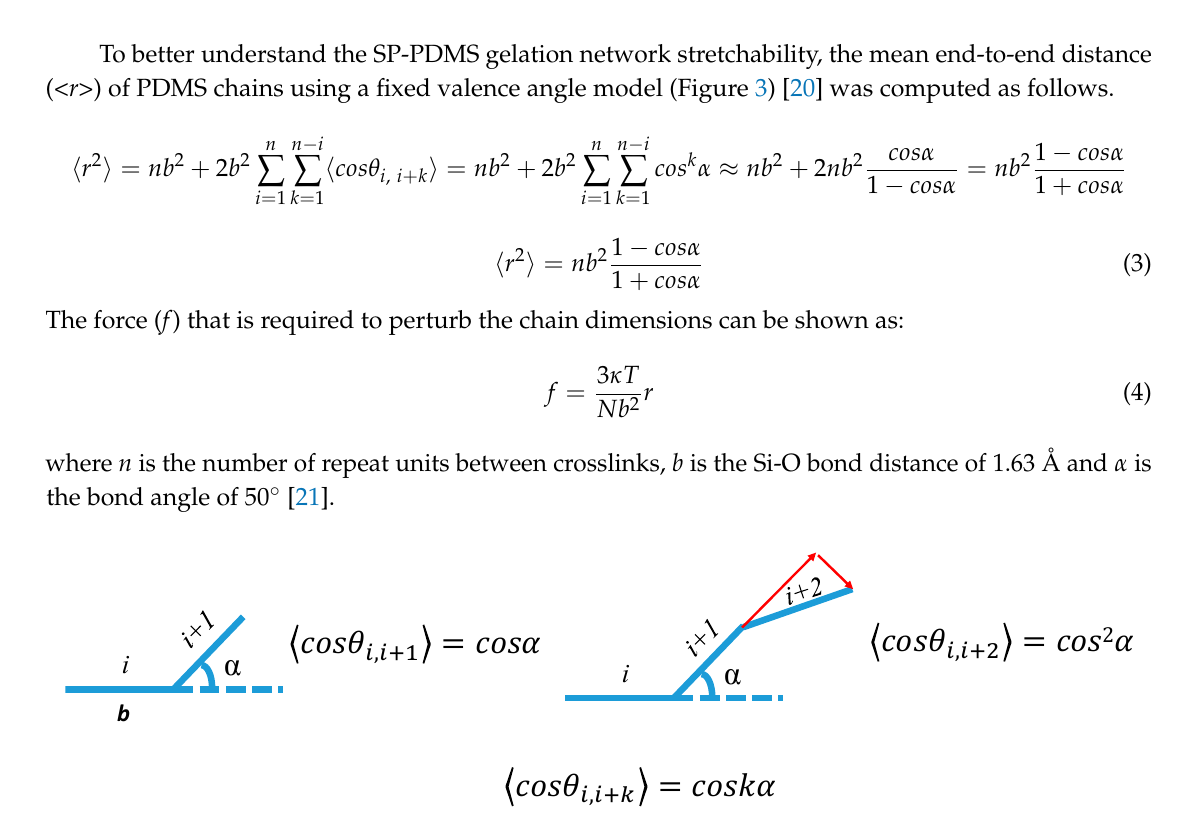
Table 1. Effect of mixing ratio on the structure and performance of PDMS network structure. Tensile test strain rate was 0.014 s − 1